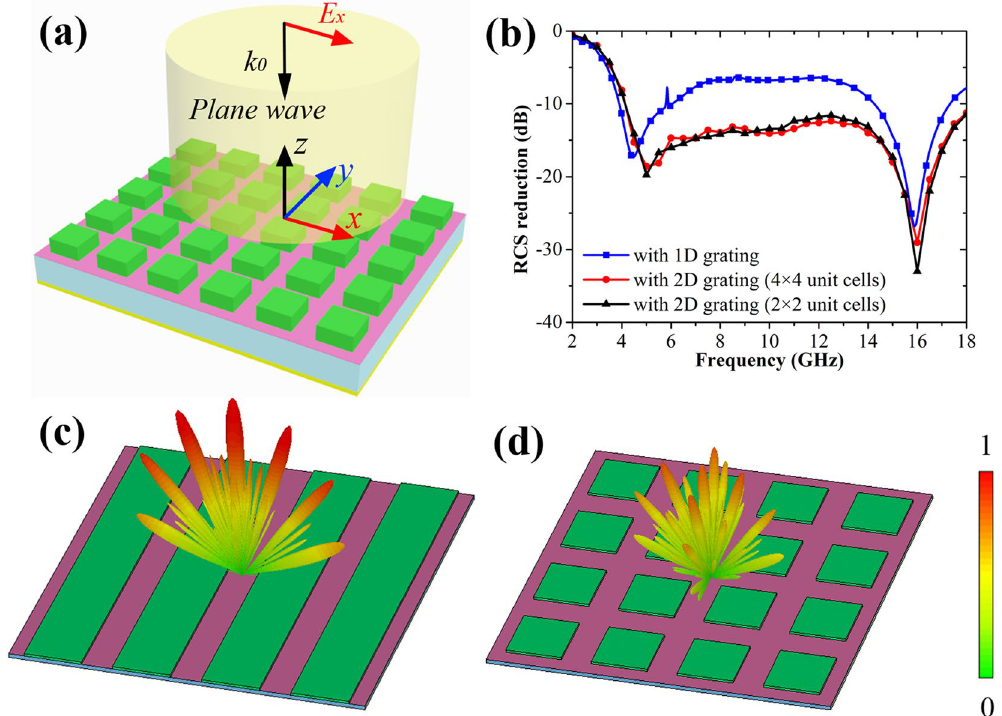
Figure 4. Schematic of the proposed 2D grating integrated Salisbury screen and its RCS reduction performance. ( a ) 3D-view of the 2D grating integrated Salisbury screen. ( b ) Simulated RCS reduction performance of the grating integrated Salisbury screen under normal incidence. ( c , d ) Simulated 3D scattering patterns of the proposed 1D and 2D grating integrated Salisbury screen at 10